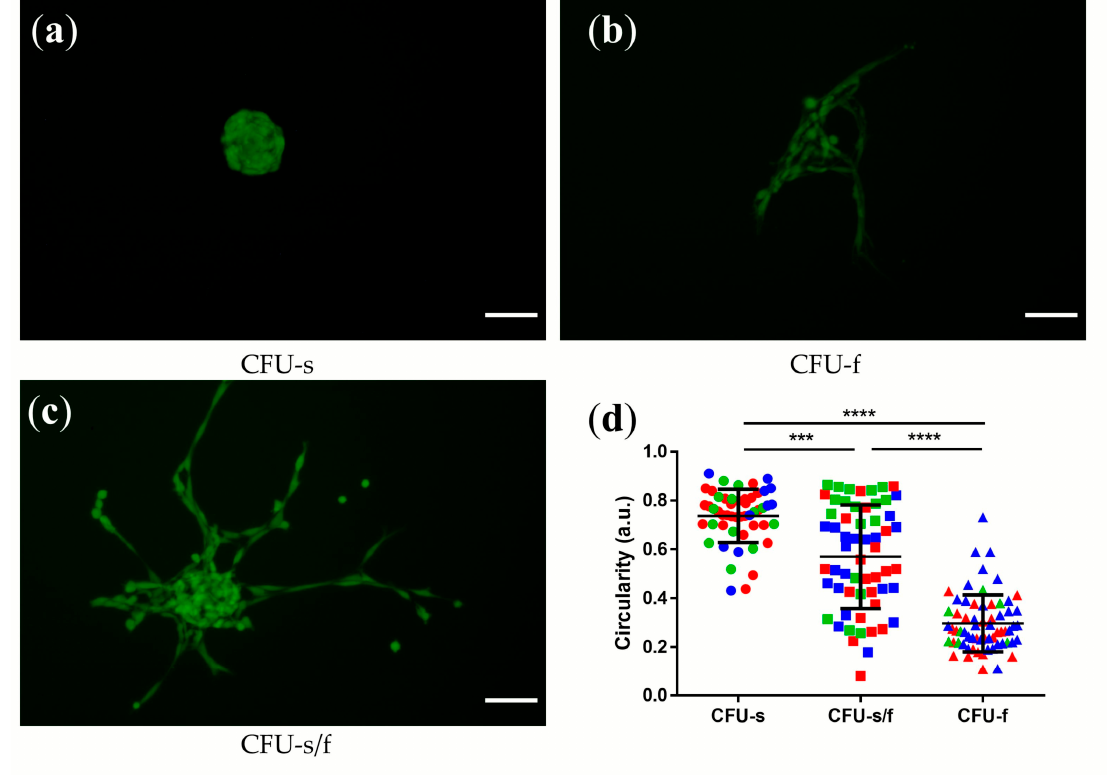
Figure 2. Phase-contrast microscopy images (10x) of three types of colony-forming units (CFU): ( a ) spheroid-type (CFU-s), ( b ) fibroblastic type (CFU-f), and ( c ) semi-spheroid-and-fibroblastic type (CFU-s/f); the NPCs were stained with Calcein-AM; scale bar = 100 µm ( d ) Cell’s circularity of different types of clones; “a.u.” refers to arbitrary units. Each dot represents one cell (n = 120), taken from three donors of patients marked in red, green, blue; Kruskal–Wallis (K-W) signed rank test, p = 0.0013 (CFU-s vs. CFU-s / f), *** = p -value < 0.001, **** = p -value < 0.0001. Lines in ( d ) represent means ± standard deviation